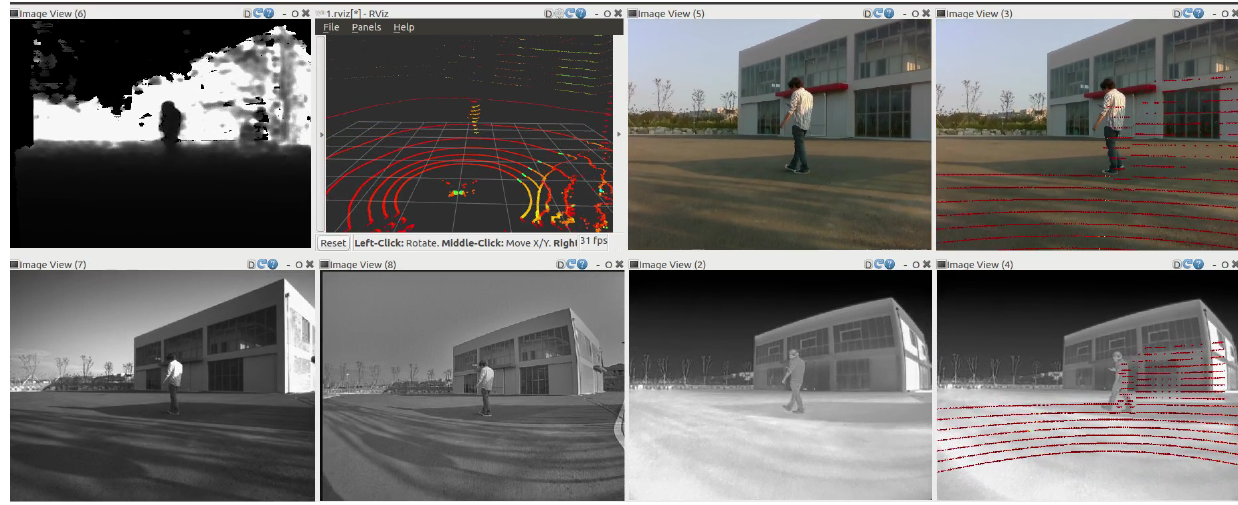
Figure 15. Comparison of ( a ) click-based correspondences method and ( b ) the proposed method.